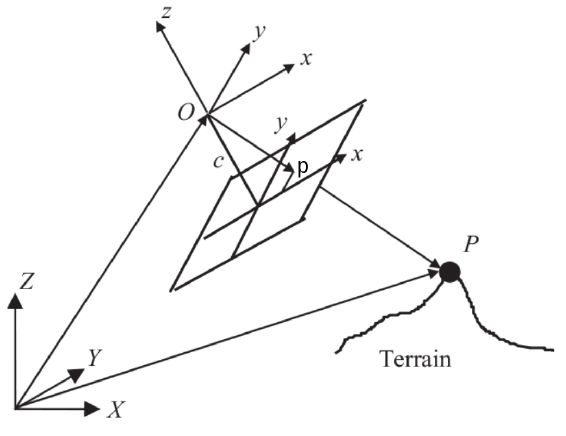
Figure 4: Imaging of a